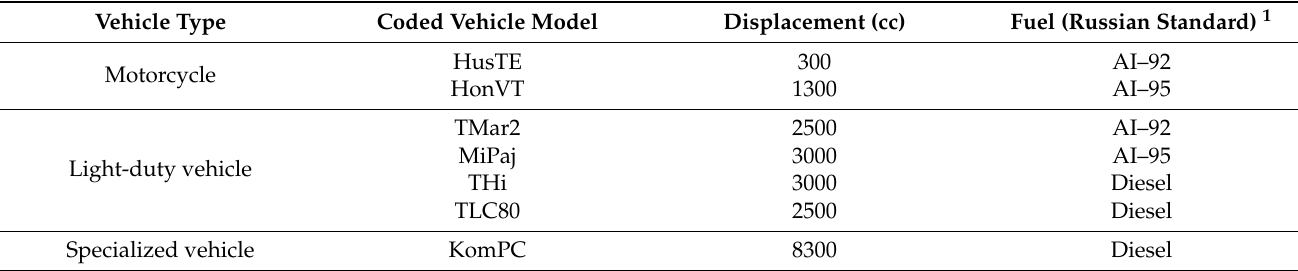
Table 1. List of the vehicles used in the